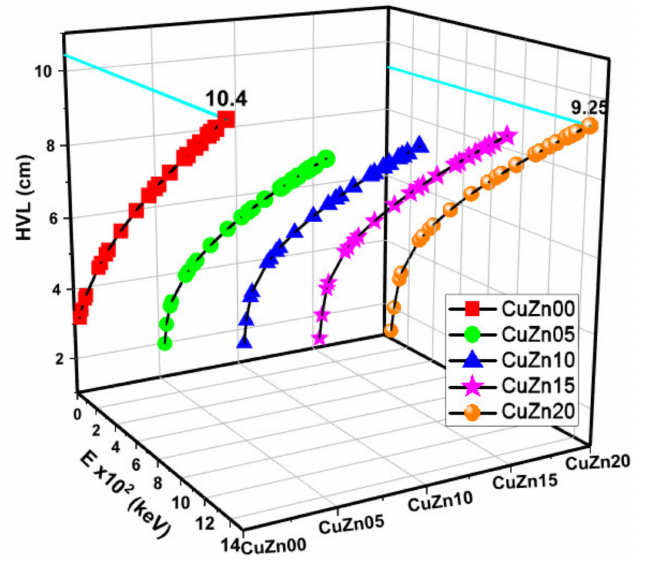
Figure 7. Half value layer (HVL) values as a function of photon energy and Cu-Zn content of